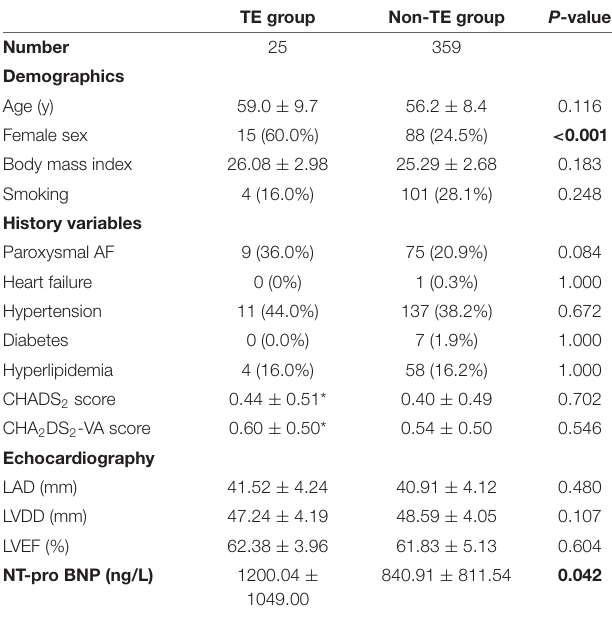
TABLE 1 | Baseline characteristics of the study population.